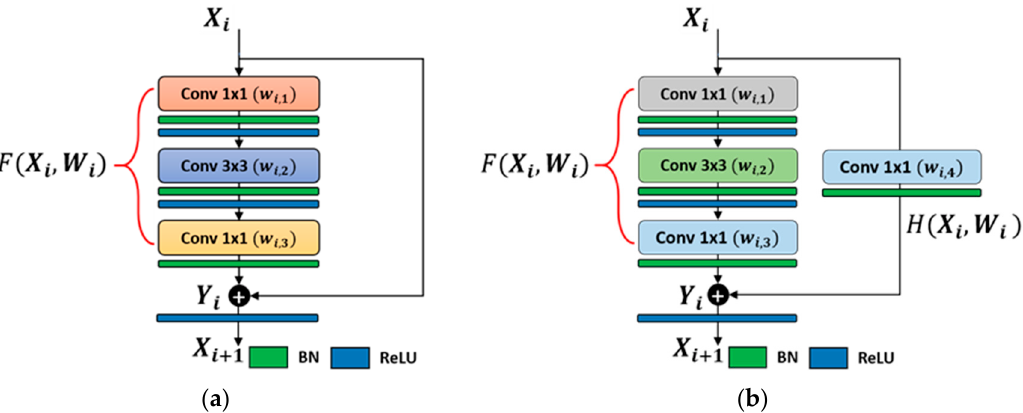
Figure 3. The residual building block of our modified ResNet50 with ( a ) identity-mapping-based residual unit, and ( b ) 1 × 1 convolutional-mapping-based residual unit.